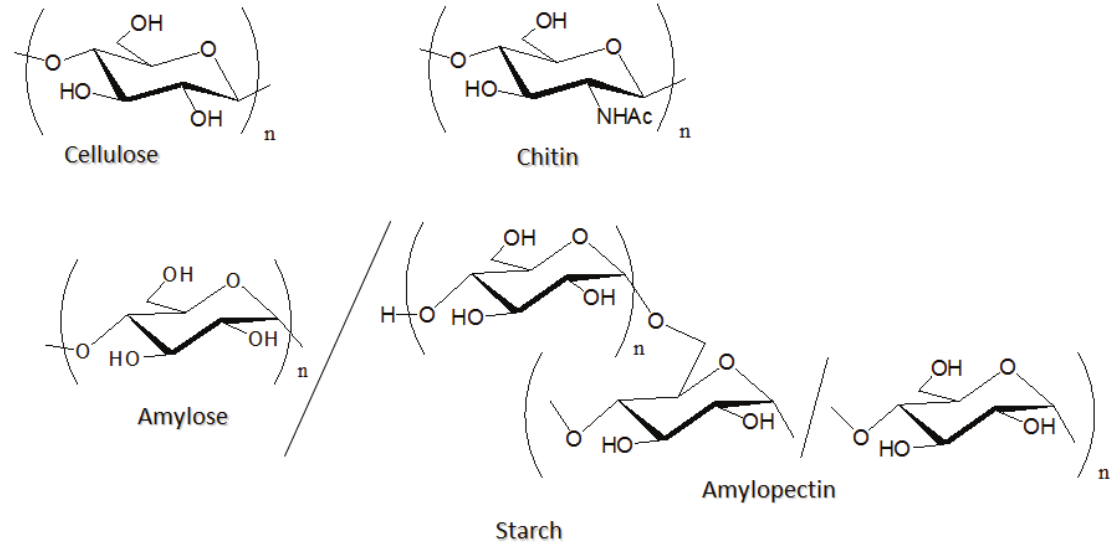
Figure 1. Structures of cellulose, chitin, and